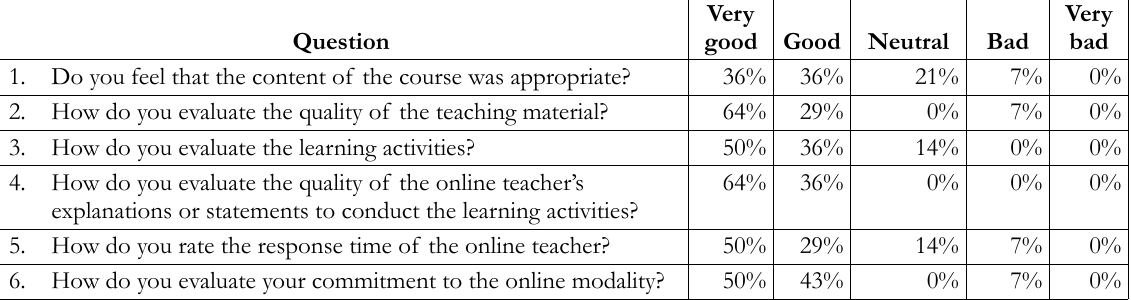
Table 10. Answers to the closed questions of the student satisfaction questionnaire